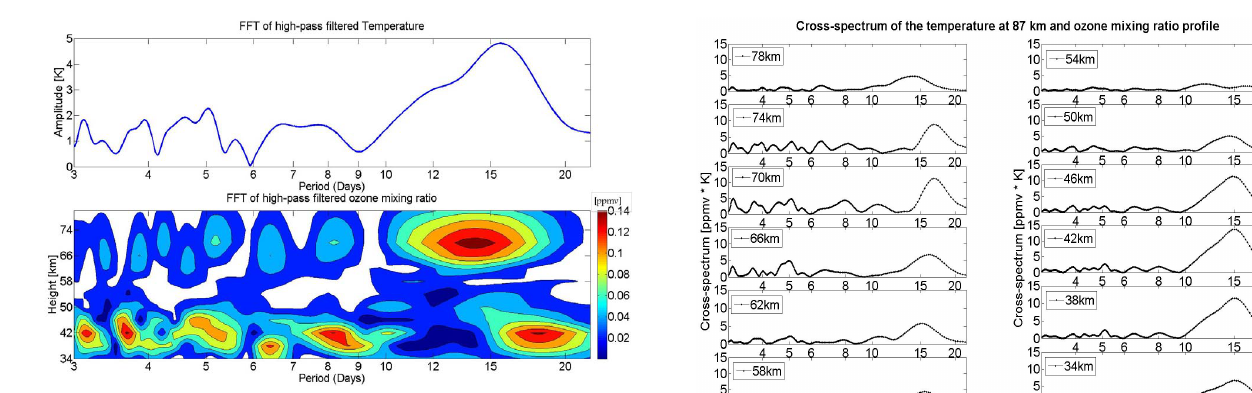
Fig. 2. FFT of the high-pass filtered temperature at 87km (top panel) and O 3 vmr profile (bottom panel) in Antarctica during win- ter 2009. Fig. 3. Cross spectrum of the temperature at 87km and O 3 vmr pro- file for winter 2009 in Antarctica for different levels in the strato- sphere and